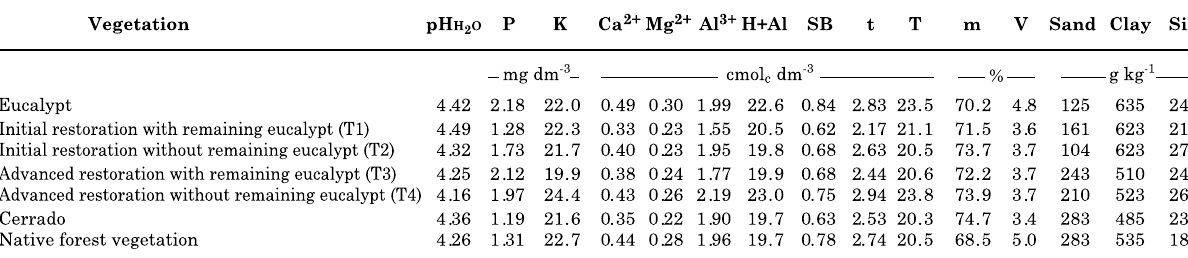
pH in water- ratio 1:2.5; P and K: Mehlich-1 Extractant; Ca 2+ , Mg 2+ and Al 3+ : KCl 1 mol L -1 Extractant; H + Al: Calcium acetate 0.5 mol L -1 Extractant ; Sand, Clay and Silt - pipette method (Embrapa, 1997); SB – Sum of bases; t: effective CEC ; T: CEC at pH 7.0; m: Al saturation ; V: base